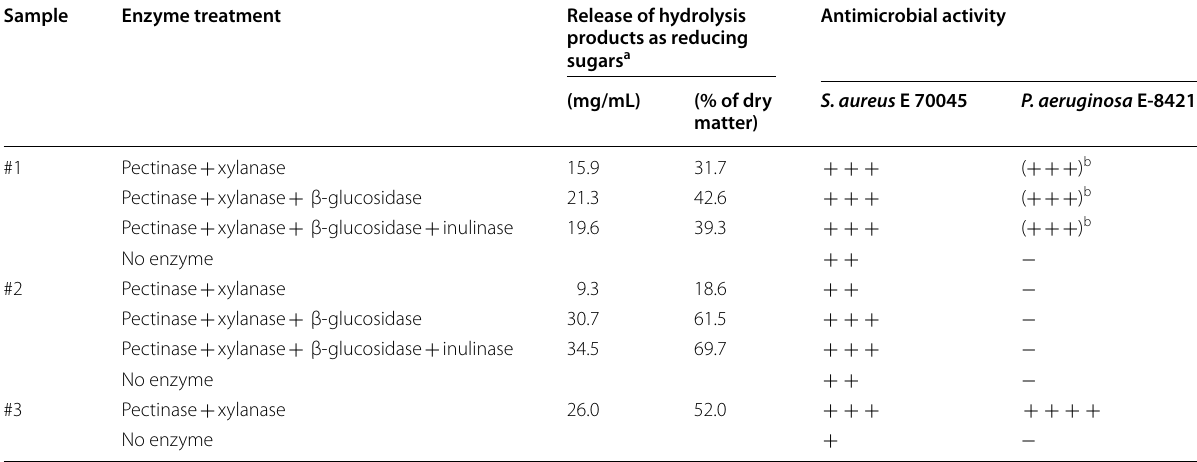
Table 2 Chicory samples #1, #2 and #3 treated with individual enzymes or mixtures (5 mg/g protein) were assessed for antimicrobial activity against S. aureus and P.